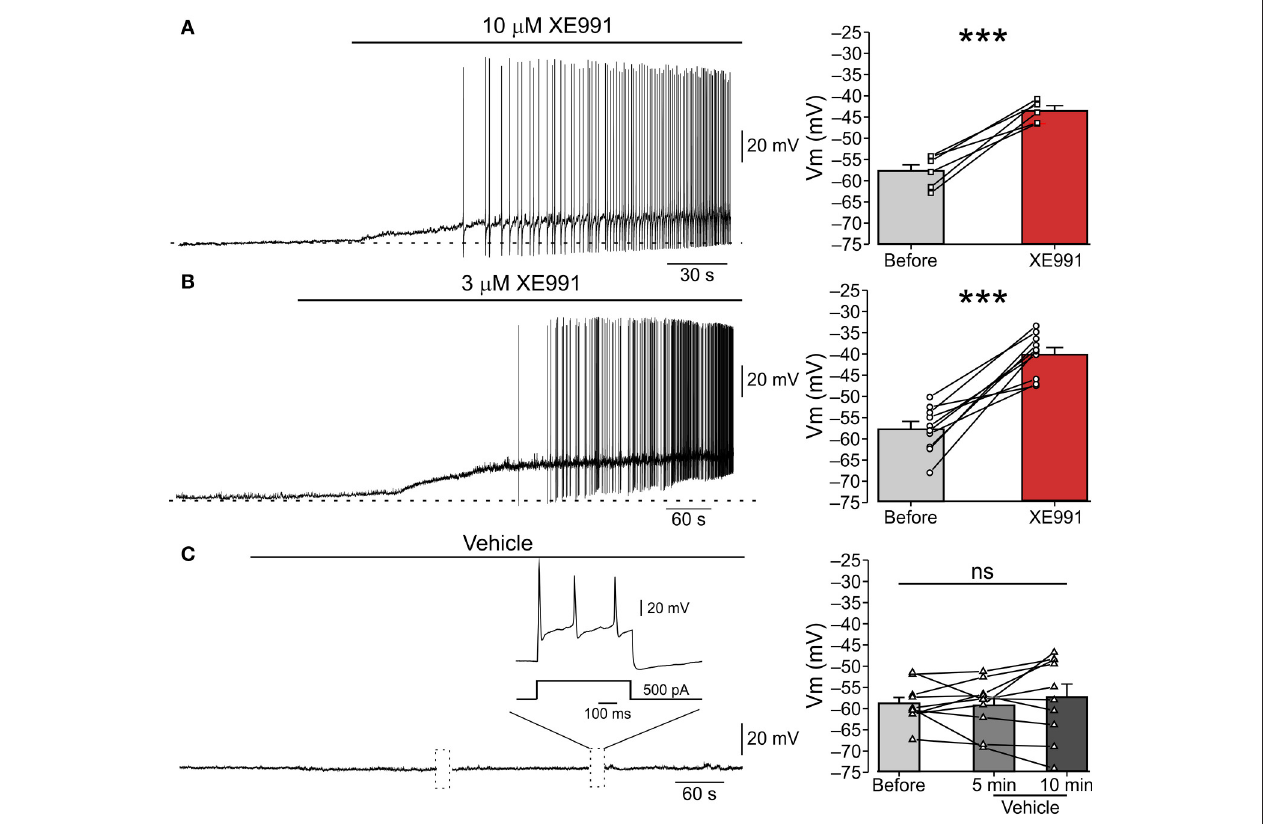
FIGURE 1 | XE991 leads to spontaneous firing of nociceptor-like DRG neurons. (A) Left, Typical responses of nociceptor-like small (25 µ m) DRG neurons to focal puff application of 10 µ M XE991 (representative of 5 out of 6 experiments). Current clamp perforated-patch recordings performed from acutely dissociated DRG neurons perfused with extracellular solution. Note, membrane depolarization and onset of spike discharges shortly after application of XE991. Dashed line indicate resting potentials before drug application ( − 58mV). Right, mean ± SEM (bar graphs) and individual neurons’ changes in membrane potential before ( gray ) and after application of XE991 ( red , measured before generation of first action potential). *** p < 0.001, paired Student t -test, n = 6. Note that XE991-induced depolarization in all recorded neurons. (B) Same as in (A) , but 3 µ M XE991 was puff-applied on the neurons. Dashed line indicate resting potential before drug application ( − 59mV). Left , representative of 10/11 neurons. *** p < 0.001, paired Student t -test, n = 11. Note that 3 µ M XE991 induced depolarization in all recorded neurons. (C) Control experiment. 10min long puff application of vehicle onto nociceptor-like DRG neuron. Note, no spontaneous depolarization developed during this period, yet the cell fired normally upon injection of depolarizing current pulses ( inset ; representative of 9 experiments). Dotted boxes show time breaks in free-run recordings when current protocols where applied. Right , same as in (A,B) , but measured 5min and 10min after puff application of vehicle; ns—not significant, one-way ANOVA, n =